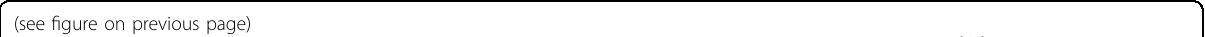
Fig. 4 Involvement of the AKT/FOXO3a/BIM pathway in TMZ-induced apoptosis of BMP4-differentiated EGFR high GSCs. a A heatmap representing RNA-seq expression of AKT1 , FOXO3 , and BCL2L11 genes in EGFR low (L0125, yellow) and EGFR high (L0615, purple) untreated glioma spheres. The results are presented on log scale. P -values shown above the heatmap were computed using the DESeq method and adjusted with the Benjamini and Hochberg method. The result of unsupervised clustering is shown on the right. b A densitometric analysis of immunoblots ( c ) shows the total and phospho-AKT (Thr308 and Ser473), total and phospho-FOXO3a (Thr32, Ser253, and Ser318) and BIM levels in untreated L0125 and L0615 spheres. Left, middle, and right panels correspond to total, phospho-AKT, and phospho-FOXO3a protein levels, respectively. Each bar and whisker represent the mean ± SD of three independent experiments. The total protein levels were normalized to those of β -actin, while the levels of phosphorylated proteins were normalized to the total level of the corresponding protein. Statistical analysis is shown in Fig. 1. c Western blot analysis of EGFR, total- and phospho-AKT, total- and phospho-FOXO3a and BIM levels upon exposure to TMZ, BMP4, or both drugs. β -actin was used as a loading control. d Densitometric analysis of phospho-AKT (Thr308) and phospho-FOXO3a (Thr32). Each bar and whisker represent the mean ± SD of three independent experiments (log-scale). The levels of phosphorylated proteins were normalized to the corresponding total protein levels. See legend for Fig. 1f for more details. The horizontal P -values correspond to comparisons between TMZ- and BMP4 + TMZ-treated cells and were computed with the post hoc test. e BCL2L11 gene expression in EGFR low and EGFR high cells after the treatments. The left and right panels correspond to L0125 and L0615 glioma spheres, respectively. The expression estimations are average values from the RNA-seq data of two independent experiments. The dashed lines correspond to TMZ treatment alone, while the solid lines correspond to pretreatment with BMP4 and subsequent treatment with TMZ. The adjusted P -value shown above the panels was computed using DESeq and was adjusted using the Benjamini and Hochberg method. f Densitometric analysis of BIM protein levels ( n = 3). The bars and whiskers represent the means and SD (log-scale). The total protein levels were normalized to those of β -actin. See legend for Figs. 1f and 4d for more details. g A schematic summary of the obtained results. The left and right panels correspond to EGFR low and EGFR high glioma spheres, respectively. In EGFR low cells, BMP4 stimulation triggers G1 cell cycle arrest, which leads to low BCL2L11 expression and blocks TMZ-triggered cell death. In contrast, TMZ treatment of BMP4-differentiated EGFR high cells upregulates the level of the pro-apoptotic protein BIM via AKT inactivation, increases FOXO3a dephosphorylation and promotes its translocation into the